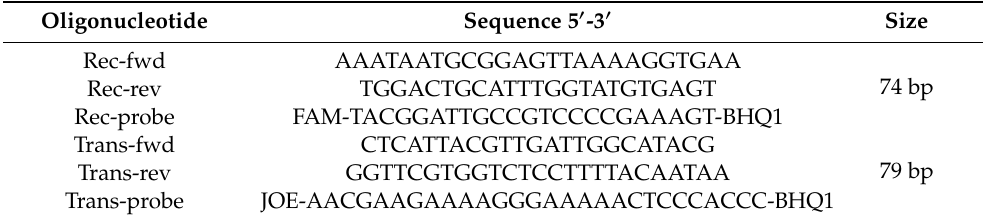
Table 1. Primers and probes sequences for Rec and Trans real-time